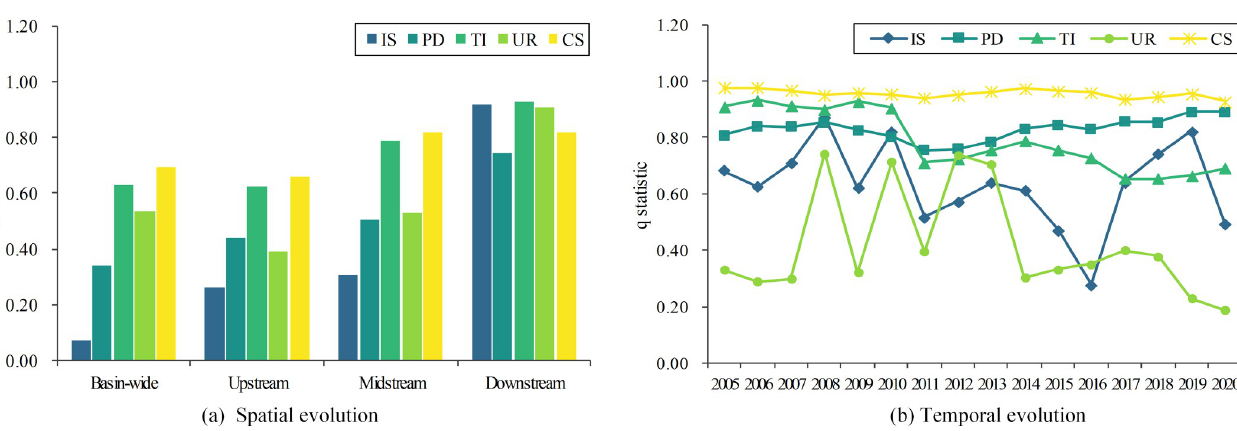
Fig 7. Spatial and temporal evolution of the driving force of external